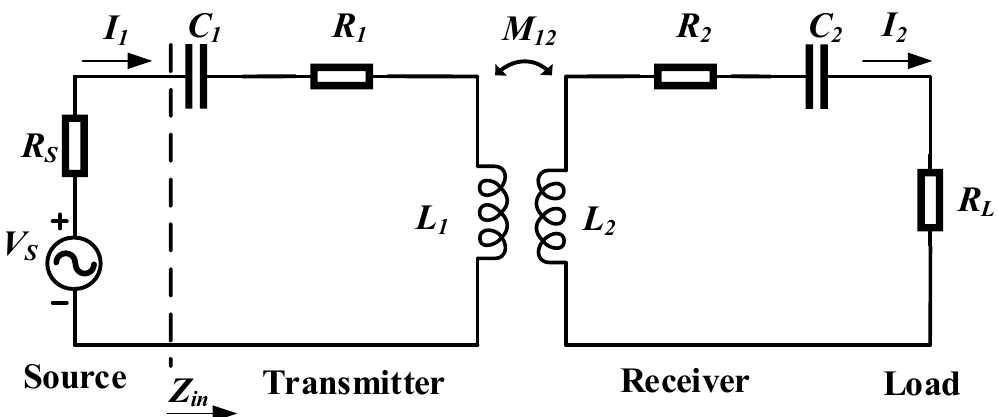
Figure 2. Simplified equivalent circuit of the WPT system with the SS compensation topology.